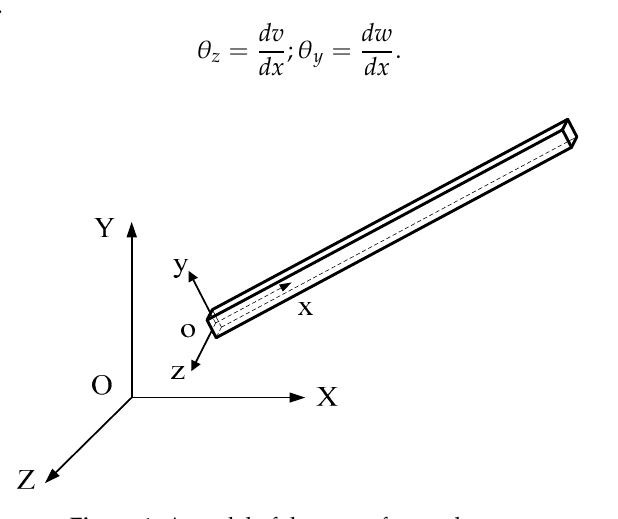
Figure 1. A model of the space frame element.